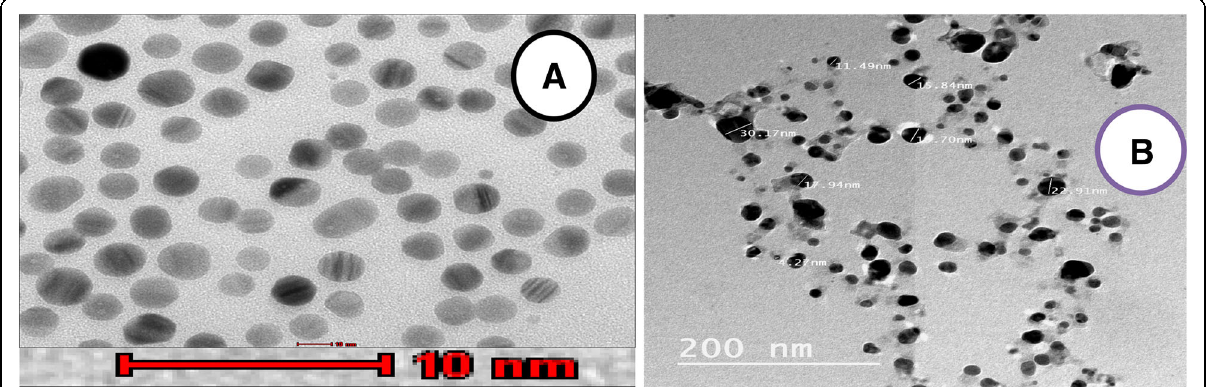
Fig. 2 The transmission electron micrographic image of a AgNPS only and b